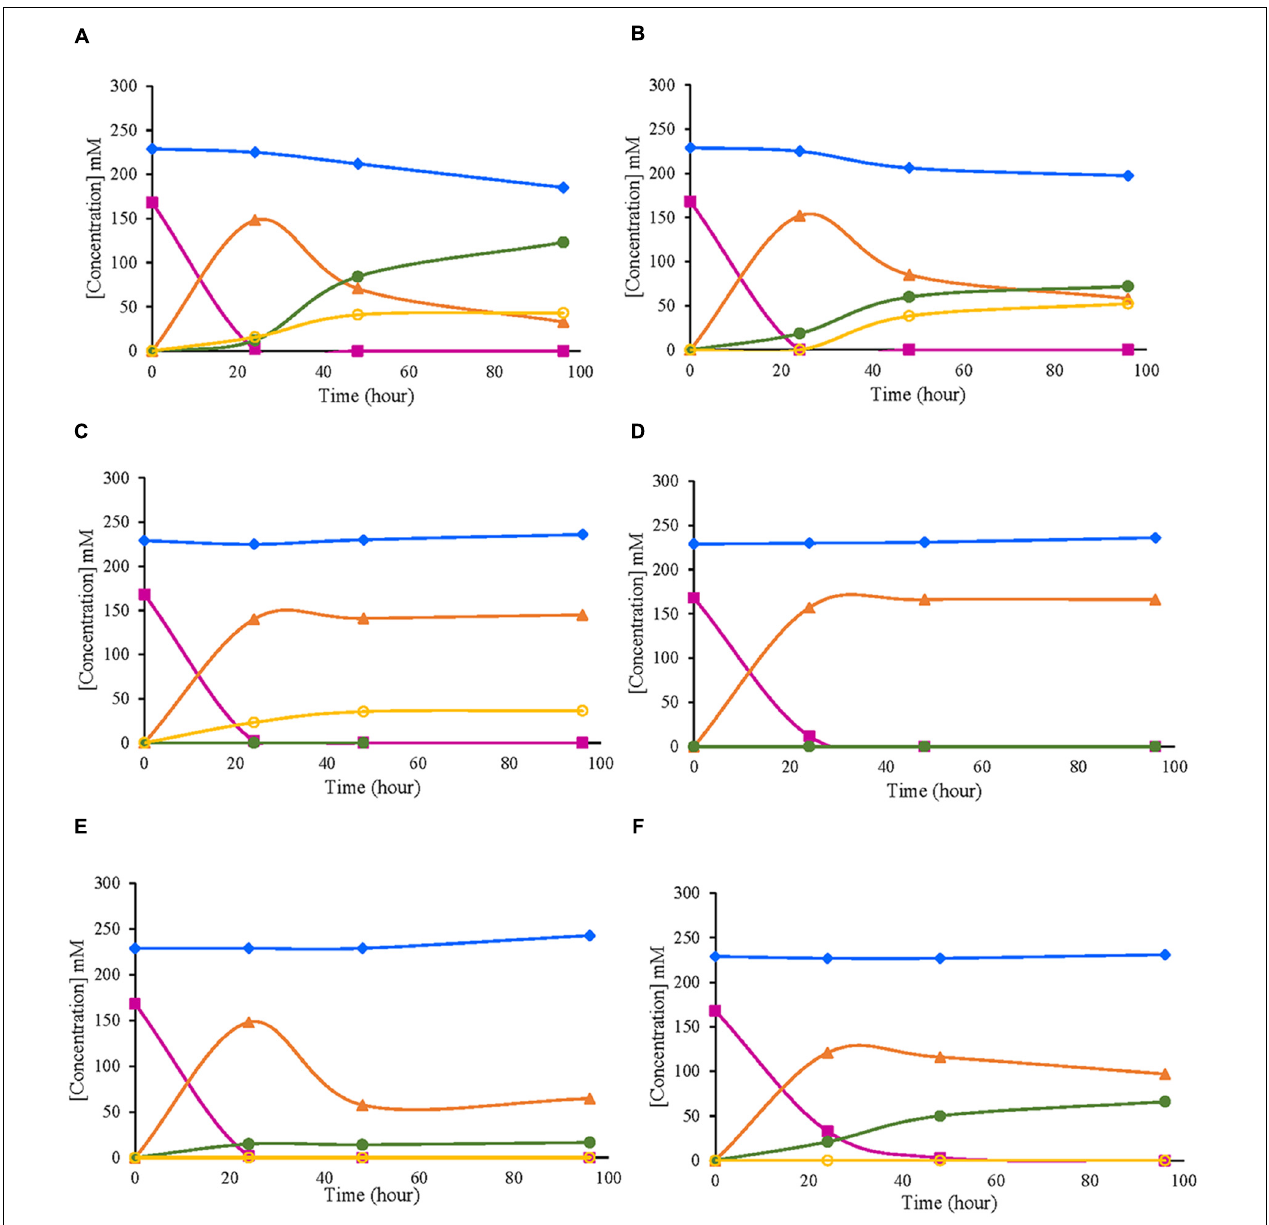
FIGURE 4 | Evolution of metabolites derived from D -glucose oxidation by six different strains of acetic acid bacteria. (A) Gluconobacter japonicus NBRC 3271; (B) Gluconobacter japonicus CECT 8443; (C) Gluconobacter oxydans 621H; (D) Gluconobacter oxydans Po5: (E) Acetobacter malorum NBRC 108912; (F) Acetobacter malorum CECT 7742. D -glucose ( (cid:4) ); D -fructose ( (cid:117) ); D-gluconic acid ( (cid:78) ); 2-keto- D -gluconic acid (